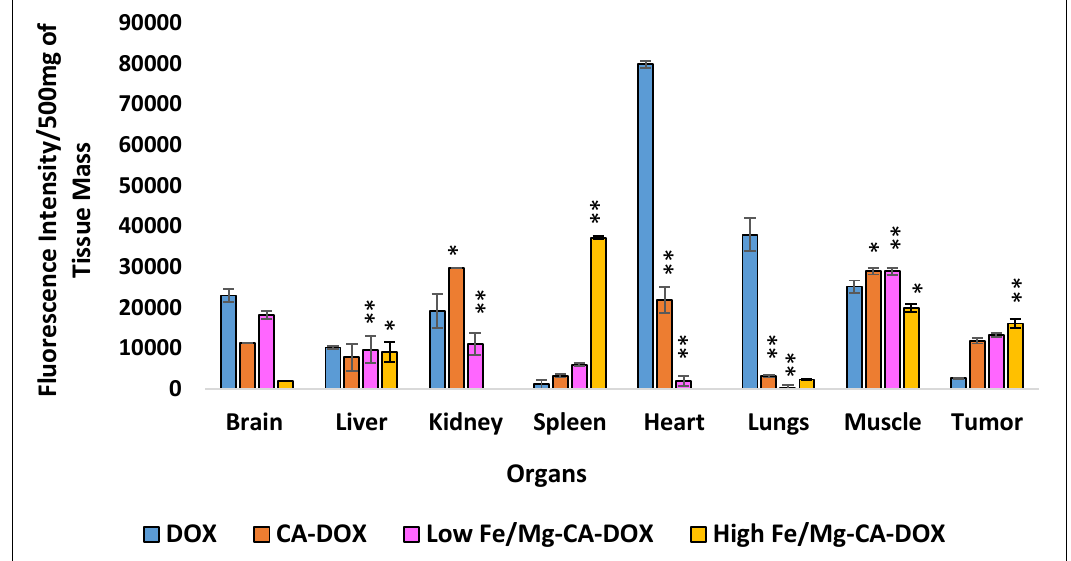
Figure 17. Tissue distribution of DOX in Balb/c 4T1 tumor-bearing mice after 24 h of intravenous injection with DOX solution, DOX-CA NPs, DOX-low Fe/Mg-CA NPs and DOX-high Fe/Mg-CA NPs. Results were considered significant at p-value 0.01–0.05 (*), very significant at p-value 0.001–0.01 (**), highly significant at p-value 0.0001–0.001 (***) and extremely significant at p-value ˂ 0.0001 (****). P values were calculated with respect to control (DOX in media) and treatment (DOX bound NPs). The confidence interval was 95% for the respective samples.